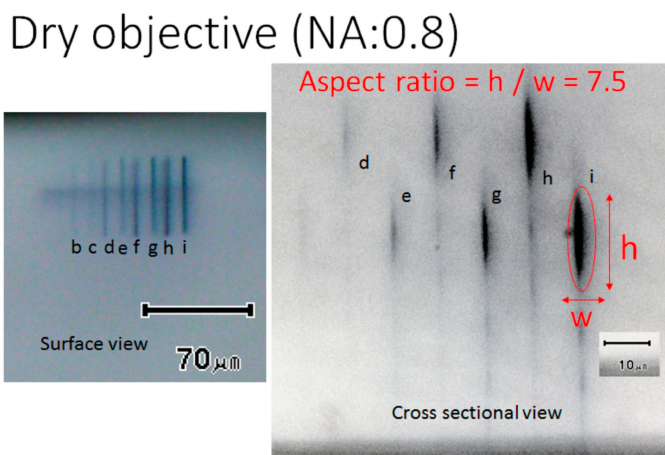
Figure2. Surfaceandcross-sectionalopticalmicrographsofphotofabricatedpoly(3,4-ethylendioxythiophene) (PEDOT) line patterns in the transparent Nafion 117 sheet. The photofabrication was carried out by using the dry objective lens (NA: 0.8) and laser focus scanning with a pitch of 0.2 µ m, wait of 50 ms, incident laser exposure of a: 0.12, b: 0.19, c: 0.25, d: 0.32, e: 0.38, f: 0.45, g: 0.52, h: 0.61, i: 0.645 mWs, and a repetition rate of 8 MHz. The laser scans were performed nine times, but eight lines were observed from the surface view. (Among them, only five lines could read the dimensions.).